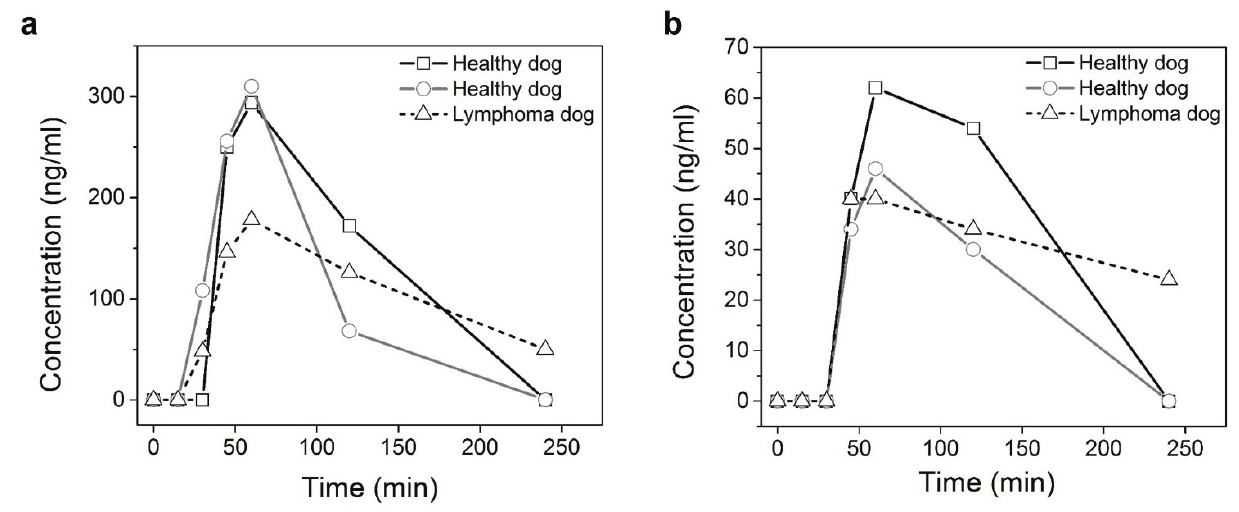
( b ) following single 1.7 mg/kg oral administration of lomustine in three